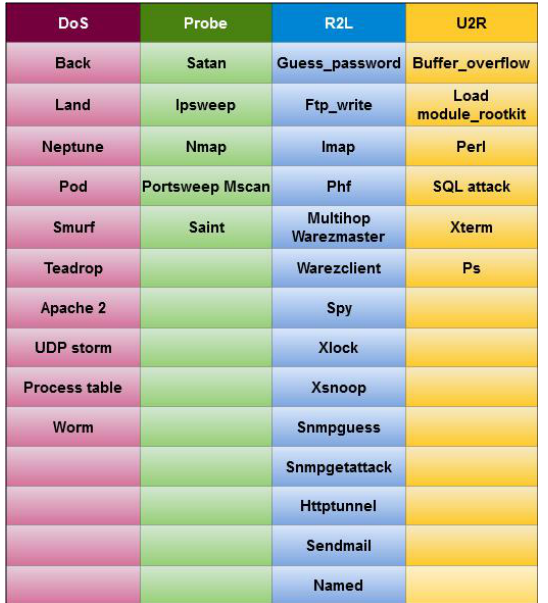
Figure 5. ROC analysis for the BoT-IoT dataset.